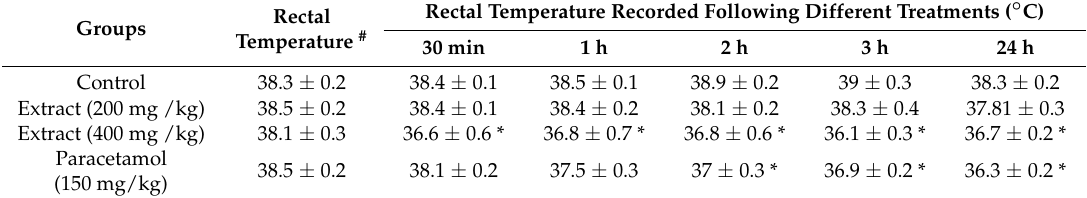
Table 4. Effect of treatment with A. zerumbet extract in a dose of 200 and 400 mg/kg or paracetamol in a dose of 150 mg/kg on Brewer’s yeast induced pyrexia in